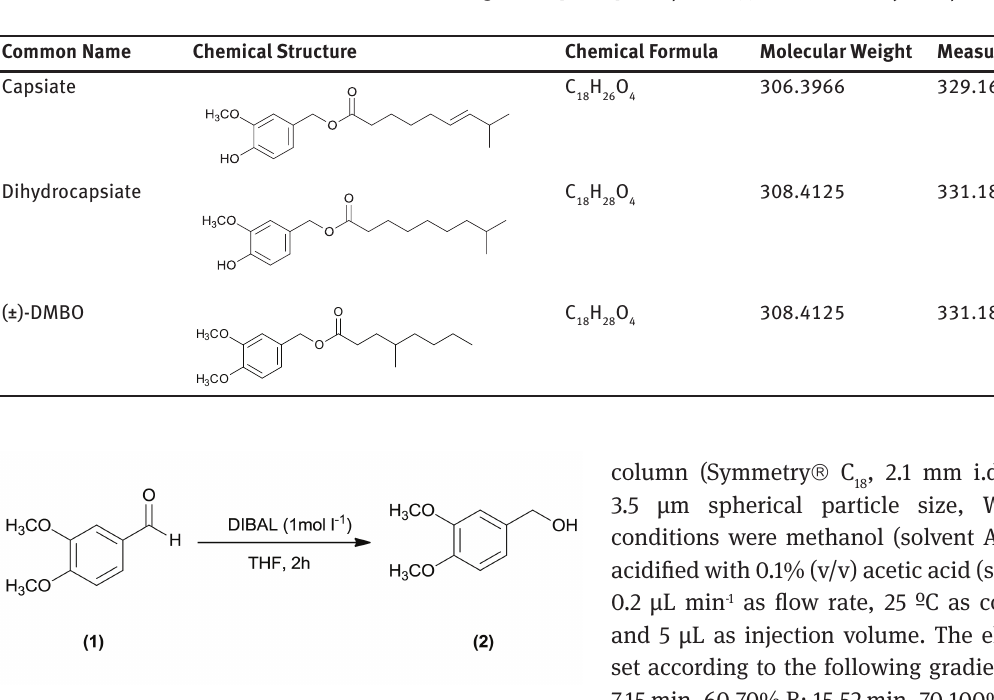
Figure 1: Step 1 of the synthesis procedure of (±)-DMBO . Reduction of 3,4-dimethoxybenzaldehyde ( 1 ) to 3,4-dimethoxybenzyl alcohol ( 2